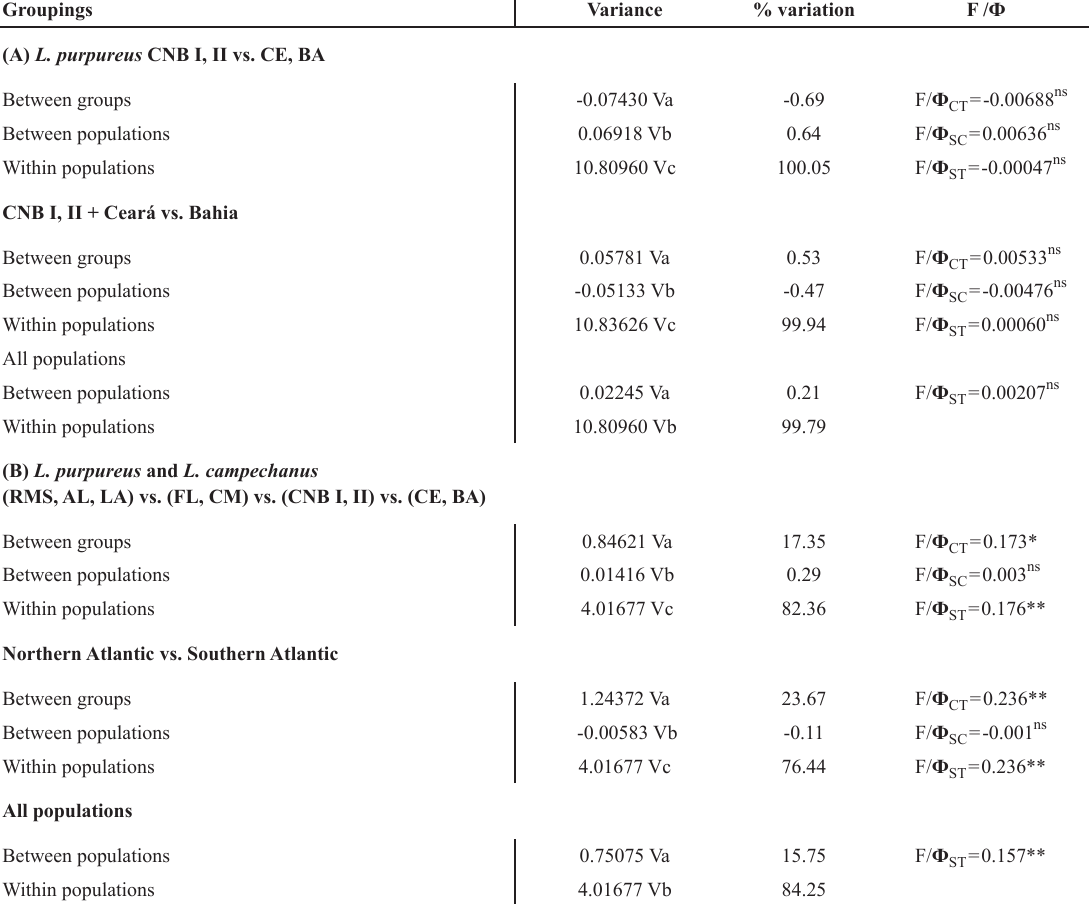
Analysis of Molecular Variance (AMOVA) for: (A) Brazilian L. purpureus (810 bps of the mitochondrial control